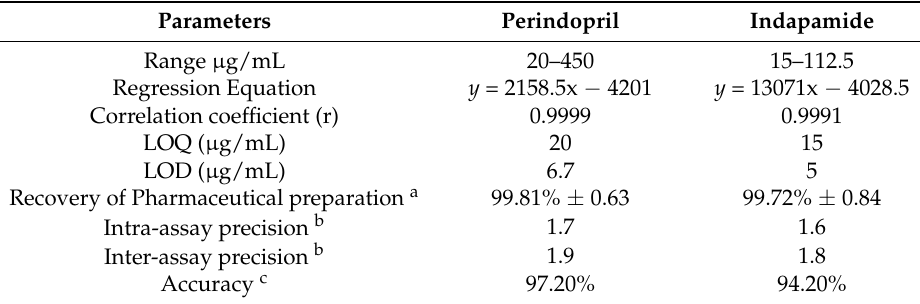
Table 2. Validation parameters of the proposed